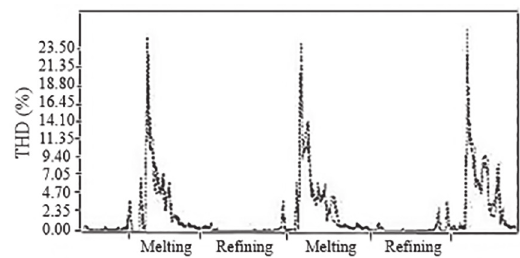
Figure 1: Total harmonic distortion during the melting and refining process 1 .